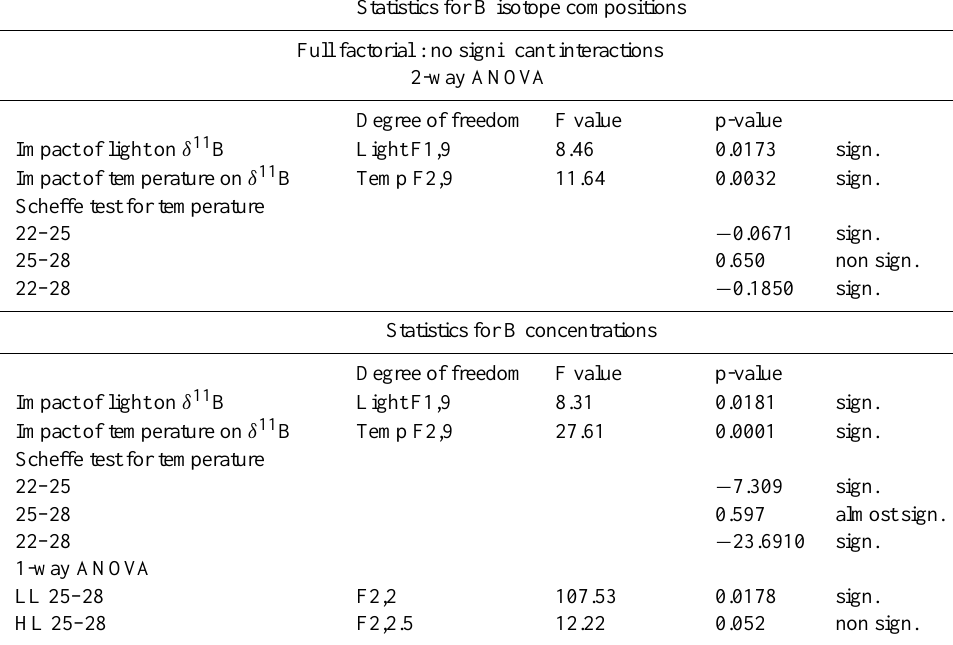
Table 5. Statistical analyses were performed with SAS version 72. A full factorial analyse was first conducted, showing no significant interactions between light and temperature variations on boron isotope compositions. Subsequently, two-way ANOVA tests were applied, showing both significant impact of light and temperature on δ 11 B. The light impact can be considered similar between the three temperature conditions. An additional SCHEFFE test was applied to test for inter comparison of temperature conditions. Significant differences of temperature on coral boron isotope composition can be observed between 22 and 25 ◦ C and 22 and 28 ◦ C, while isotopic signatures can be considered similar between 25 and 28 ◦ C. Identical statistical tests were applied to boron concentrations, showing both significant impact of light and temperature on coral boron concentrations. Significant differences of temperature can be observed between 22 and 25 ◦ C. Two additional 1-way ANOVA tests were performed to measure the impact of temperature increase from 25 to 28 ◦ C, per light condition independently. This temperature increase induces a significant increase in boron concentrations under LL, while no significant increase can be observed under HL